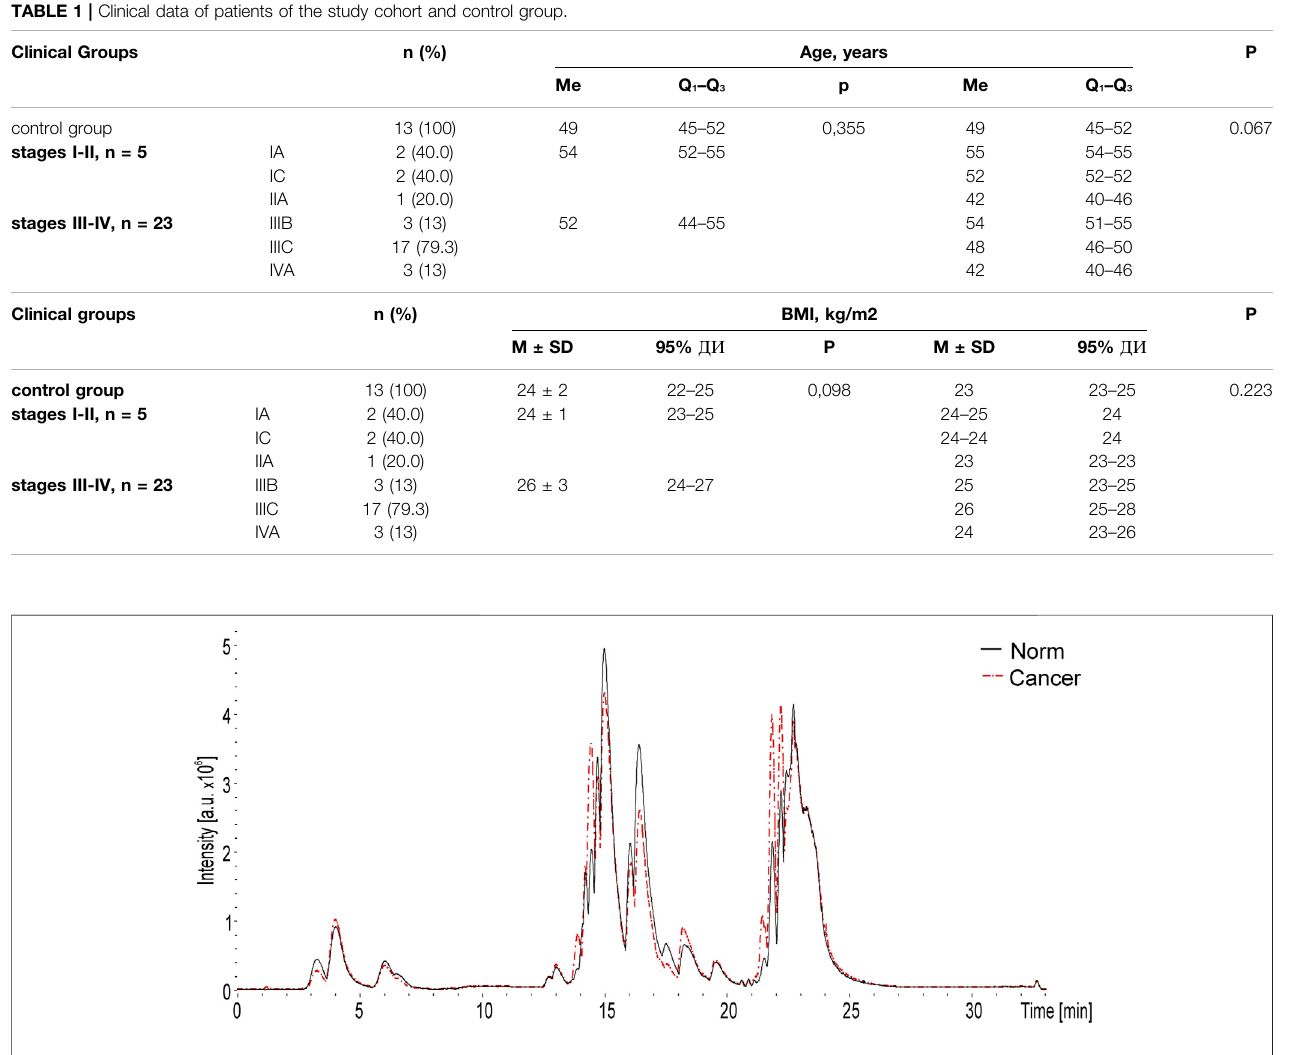
FIGURE1| Typicaltotalionchromatogram oflipidionsrecordedinthepositiveiondetectionmode. ThechromatogramwasobtainedbyHPLC-MSanalysisofthe blood plasma extract. The red curve corresponds to the sample obtained from the patient with con fi rmed OC. The black curve corresponds to the sample from the patient from the control